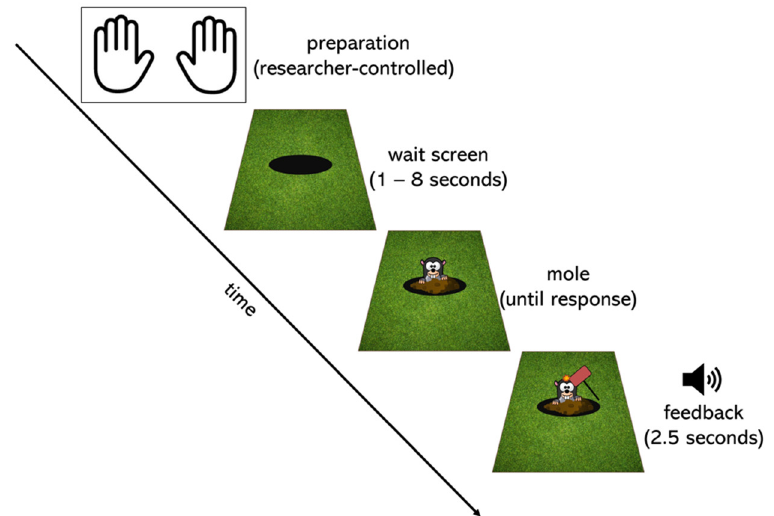
Figure 1. Graphical depiction of the task sequence. Each trial was initiated by the experimenter, ensuring that the child was in position (preparation). A black circle (a hole) on a green background (grass) then appeared for a random time wait interval ranging from 1 to 8 s (wait screen). After this interval, a mole appeared, and the child’s task was to press the button on the response box as quickly as possible (mole). When they did so, a hammer came down on the mole, and a laughing sound played for 1.5 s (feedback). Stars on the right-hand side of the screen told participants how many trials they had completed in the block. The preparation screen for the next trial then